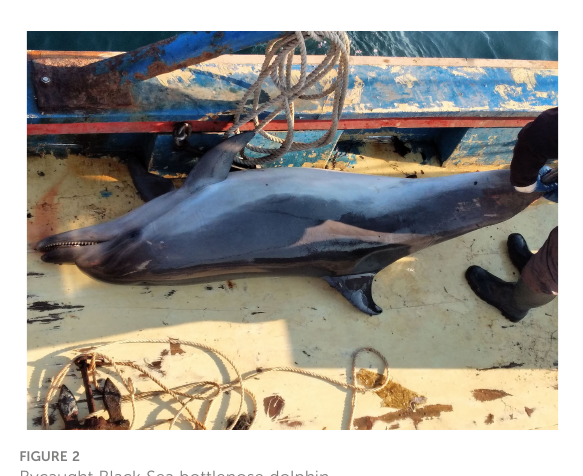
FIGURE 1 Bycaught Black Sea harbour porpoise.